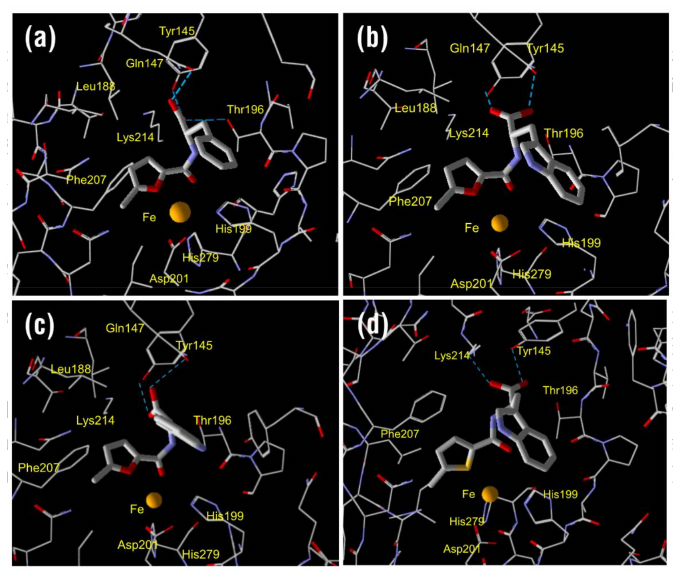
Figure 5. The predicted binding model of compound 7 , 9 , 10 (hydrolysate) , and 16 within the active center of FIH-1. ( a ) Compound 7 (hydrolysate); ( b ) Compound 9 (hydrolysate); ( c ) Compound 10 (hydrolysate); and ( d ) Compound 16 .